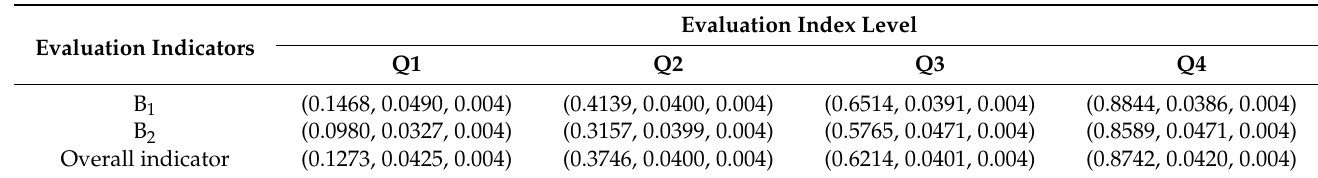
Table 5. Comprehensive standard cloud digital characteristics of each